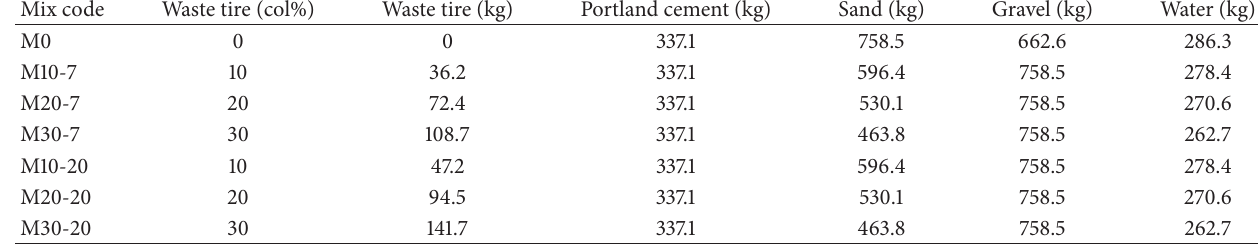
Table 4: Components of concrete (1m 3 ).